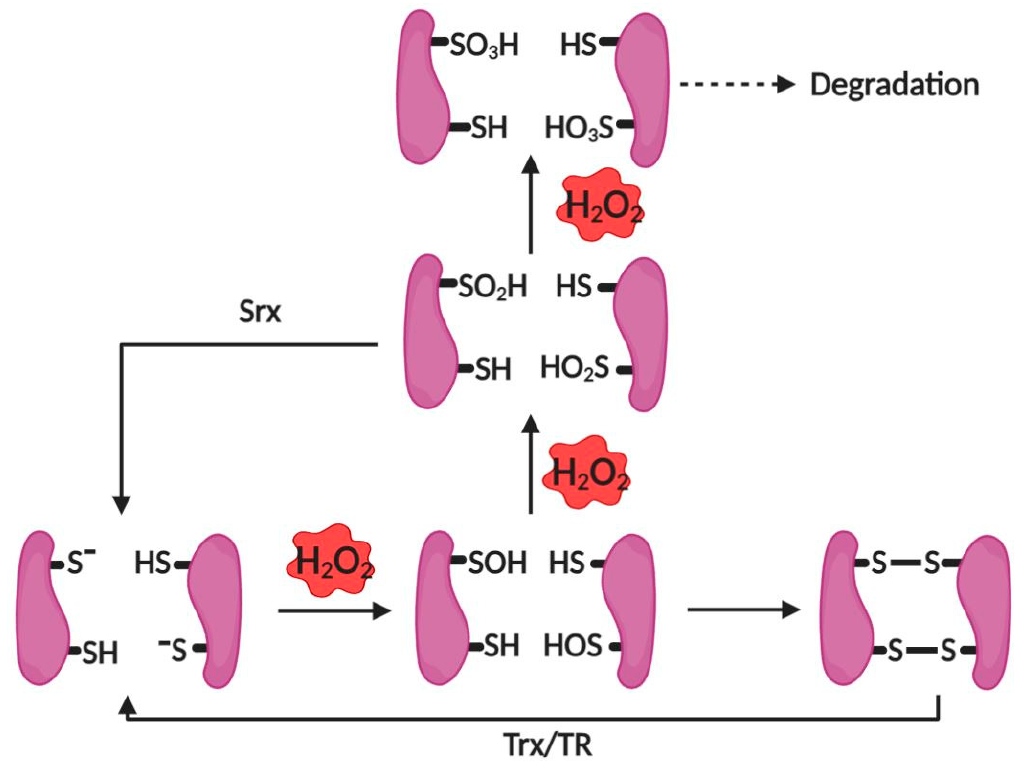
Figure 2. Reactions between Prx I, Trx, Srx and H 2 O 2.